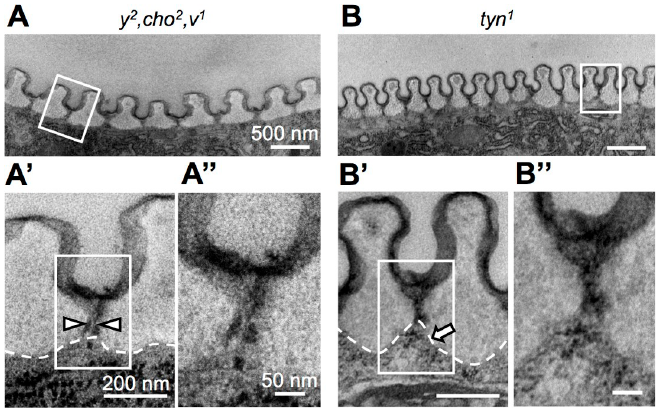
Fig 7. Defective ultrastructures in the tyn 1 mutant. (A, B) TEM images of the taenidial folds in y 2 , cho 2 , v 1 (A-A”) and tyn 1 , y 2 , cho 2 , v 1 (B-B”) in embryonic stage 17 trachea. A’, A”, B’ B” are enlarged views of the regions indicated by rectangles in A, A’, B, B’, respectively. Arrowheads in A’ indicate a pore-like structure we called the “taenidial channel” (TC). Dotted lines: plasma membrane. Arrow in B’: a prominent protrusion of the tracheal cell. Scale bars: 500 nm in A and B, 200 nm in A’ and B’, and 50 nm in A” and B”.